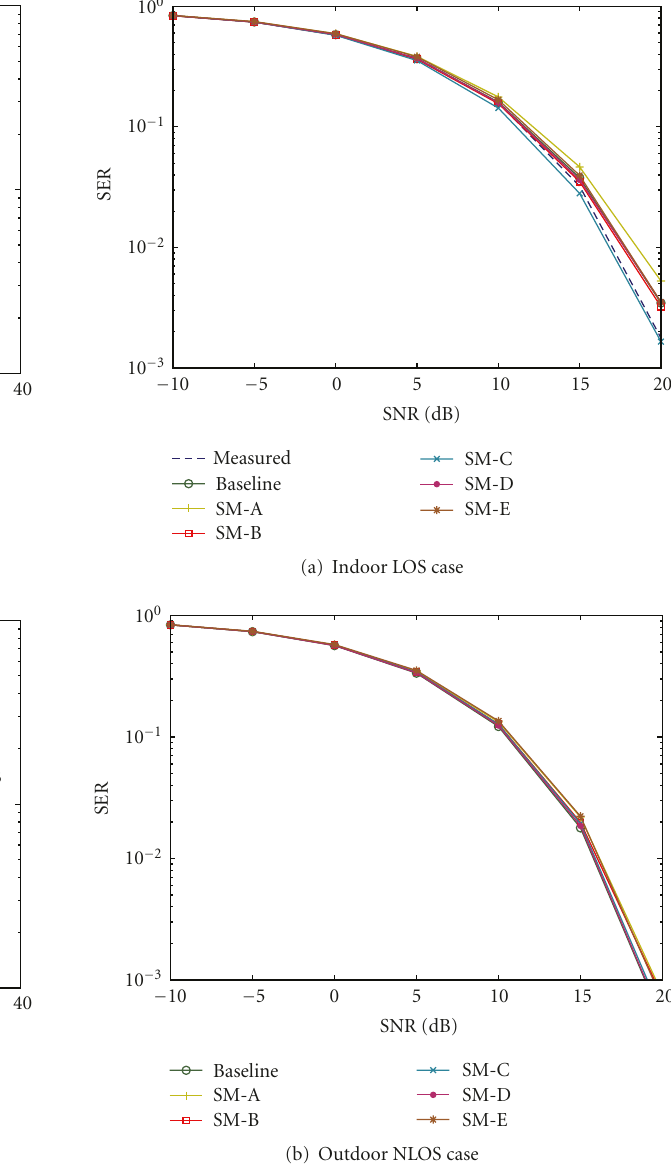
Figure 7: CDFs of MIMO capacity for baseline and simplified cases. Figure 8: SVD symbol error probabilities for baseline and simpli-